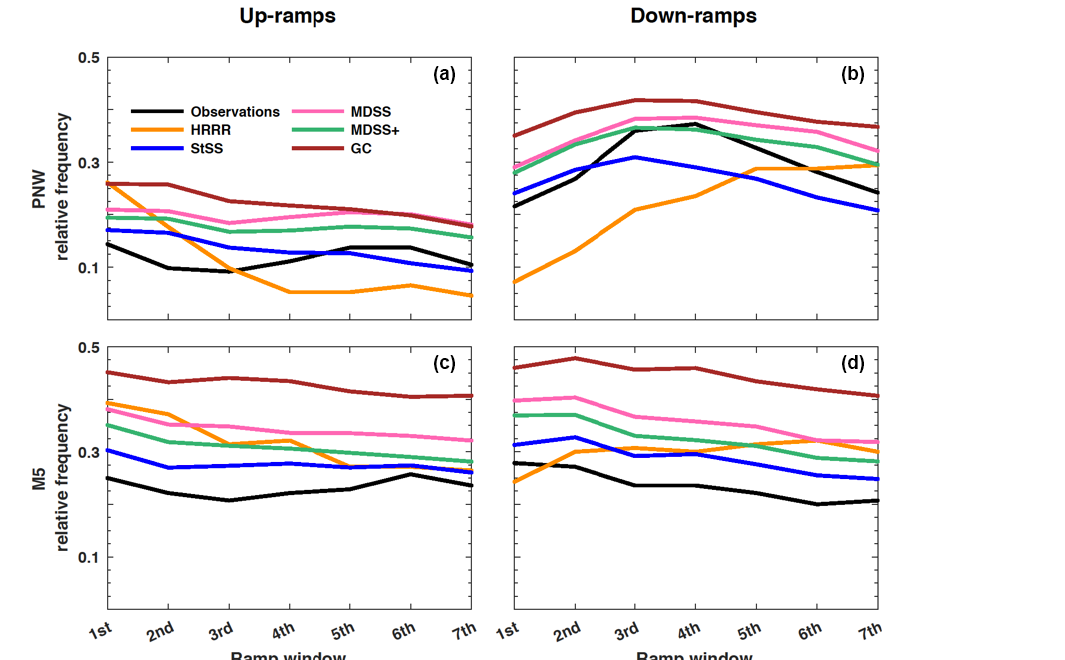
Figure 9. Relative frequency of up-ramps (a, c) and down-ramps (b, d) identified with ≥ 60% change in power capacity during each 6h time period (i.e., ramp windows) starting at 00:00UTC. Relative frequencies of observed ramps (black lines) and forecasted ramps from the HRRR model (orange lines) are shown for the PNW (a, b) and M5 (c, d) tower locations. Relative frequencies are also shown for the four different multivariate methods: standard Schaake shuffle (StSS; blue lines), minimum divergence Schaake shuffle (MDSS; pink lines), enhanced minimum divergence Schaake shuffle (MDSS + ; green lines), and Gaussian copula (GC; brown